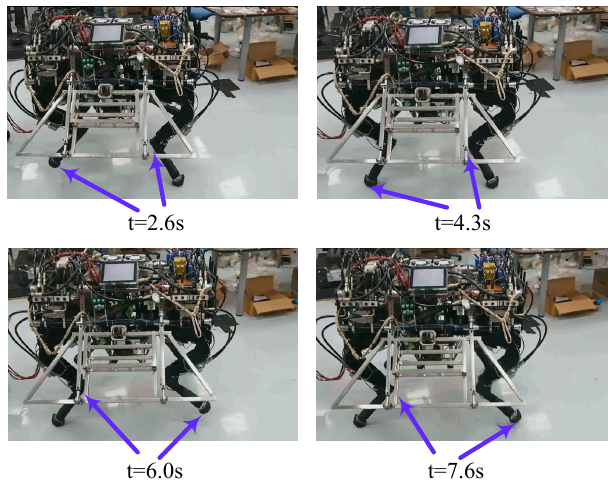
Figure 18. Trot gait diagram of experimental prototype.